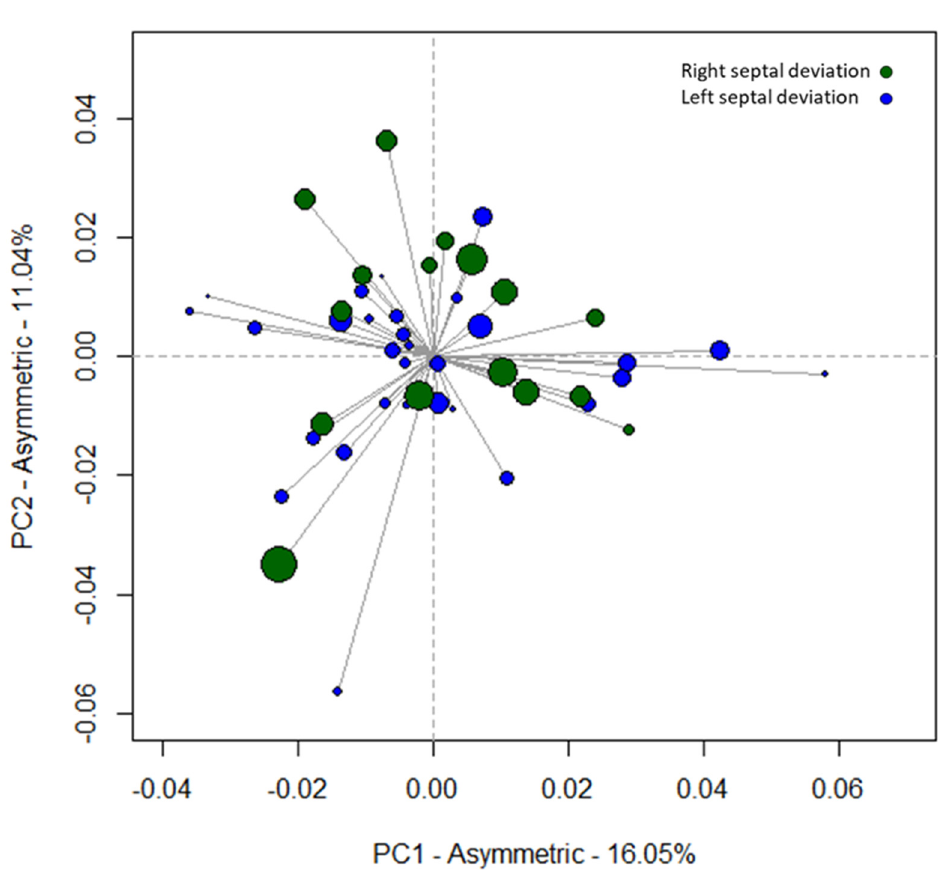
Figure 8. Principal Component Analysis (PCA) of the asymmetric component of the face in the entire sample (0 to 8 years old). Green dots indicate specimens with right septal deviation, blue dots indicate specimens with left septal deviation. PC1 and PC2 explain 16.05% and 11.04% of the total variance, respectively. Vectors indicate magnitude and direction of the patterns of facial asymmetry and distance from 0 (perfect symmetry). Dimension of circles is proportional to the magnitude of septal deviation. Sample size: 46 specimens.